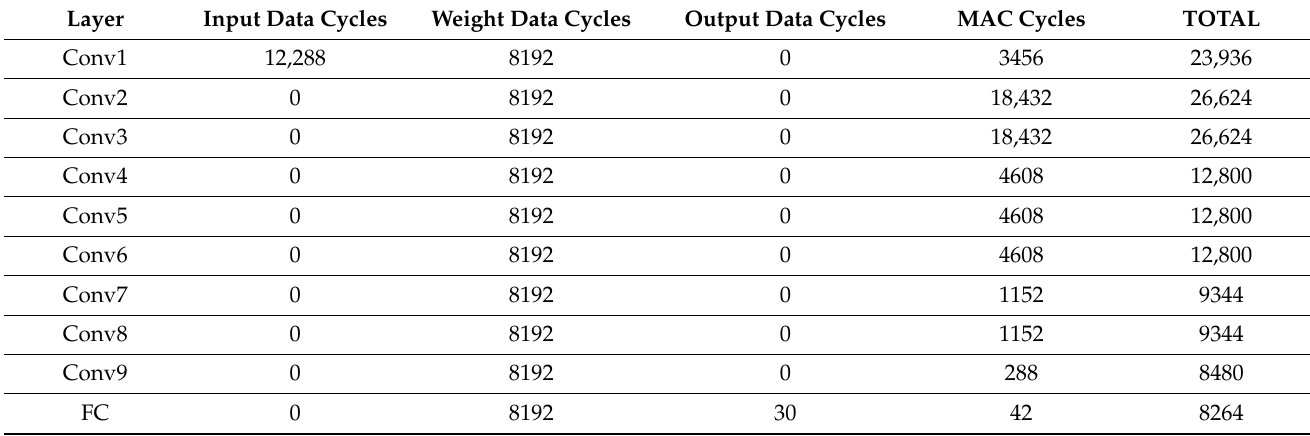
Table 3. Data and MAC cycles based on the configuration and network parameters.